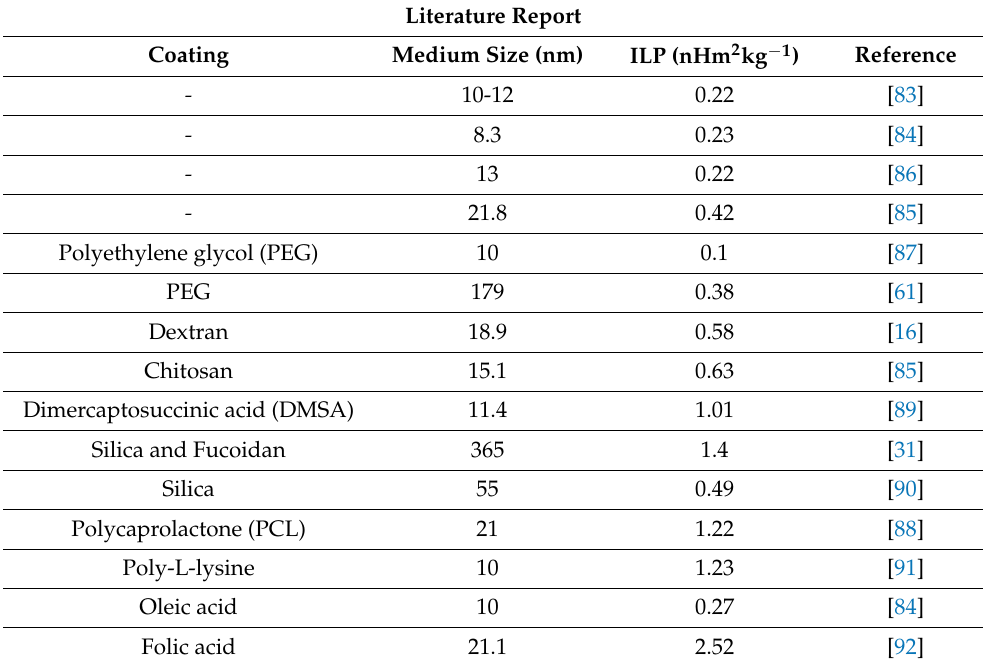
Table 4. Summarizes reported ILP values for pristine and coated magnetite NP with different coating